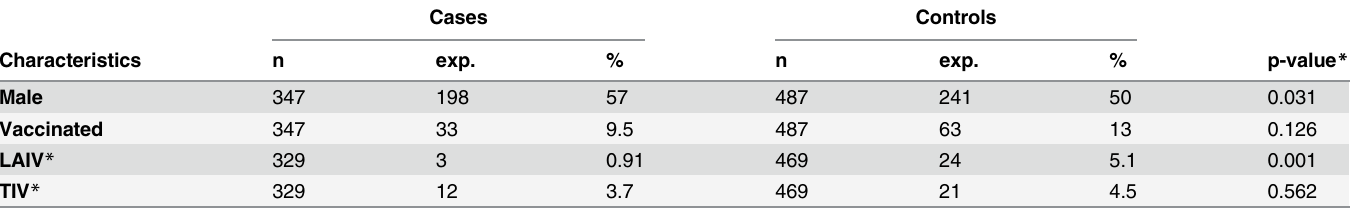
Table 3. Characteristics of influenza cases and test-negative controls, Virological Surveillance, Saxony-Anhalt, Germany 2012/13.